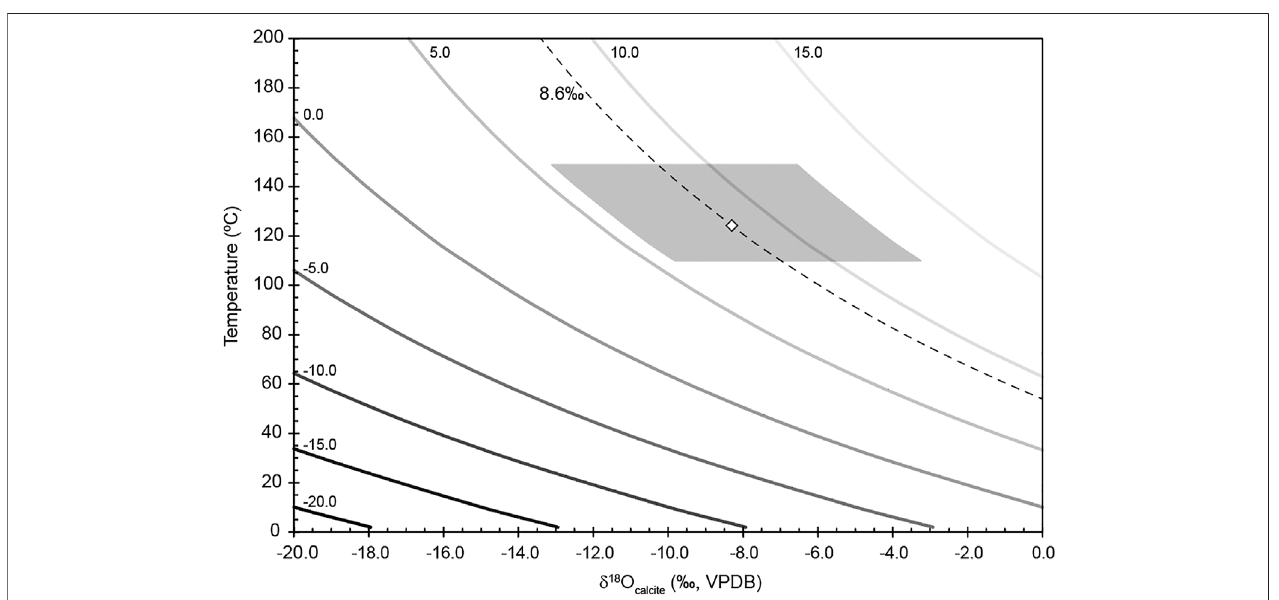
FIGURE 13 | Modelling the δ 18 O value of water from which the calcite in the vertical fractures precipitated using fl uid inclusion microthermometry and carbonate oxygenisotopesvalues.LimitsofMontneywatermodel δ 18 Oenvelopeshowningreyare:+5.7 ‰ to+12.5 ‰ ,withanaveragevalueof+8.6 ‰ ,dashedline.Temperature limits are 110 ° C – 149.4 ° C with an average homogenization temperature (123.9 ° C) and calcite δ 18 O value (-8.3 ‰ ) shown as diamond.